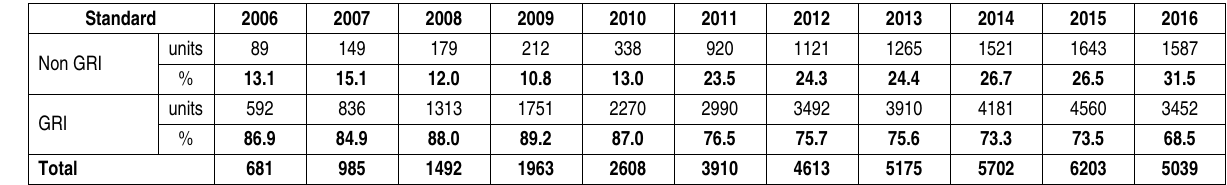
Table 6. SR standards all over the world in 2006-2016 as of 01/01/2017